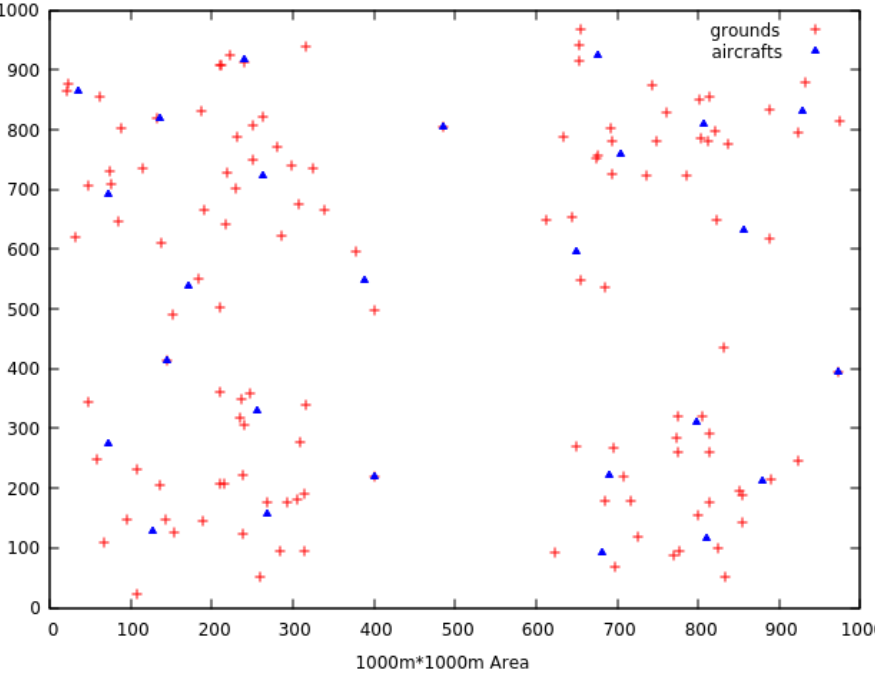
Figure 4. Set of aircraft placements obtained using true